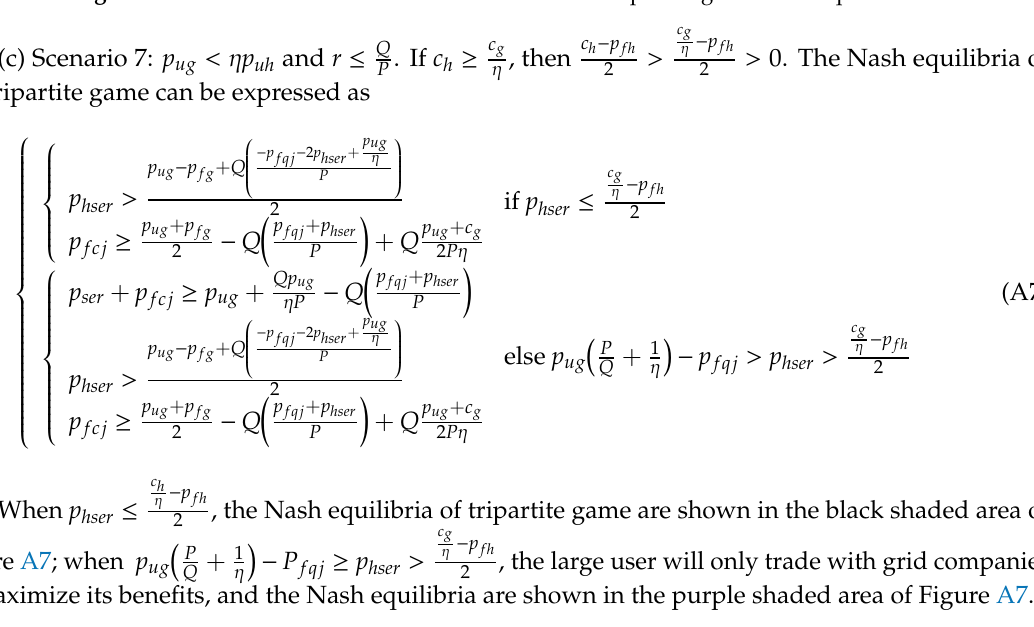
Figure A6. Scenario 6: two-dimensional sketch of the tripartite game Nash equilibria.